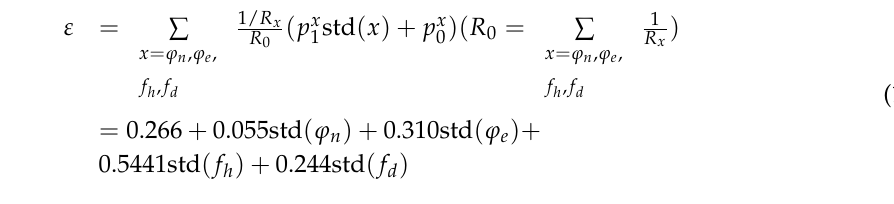
Figure 9. The relation between horizontal specific force and internal RMSE. 1